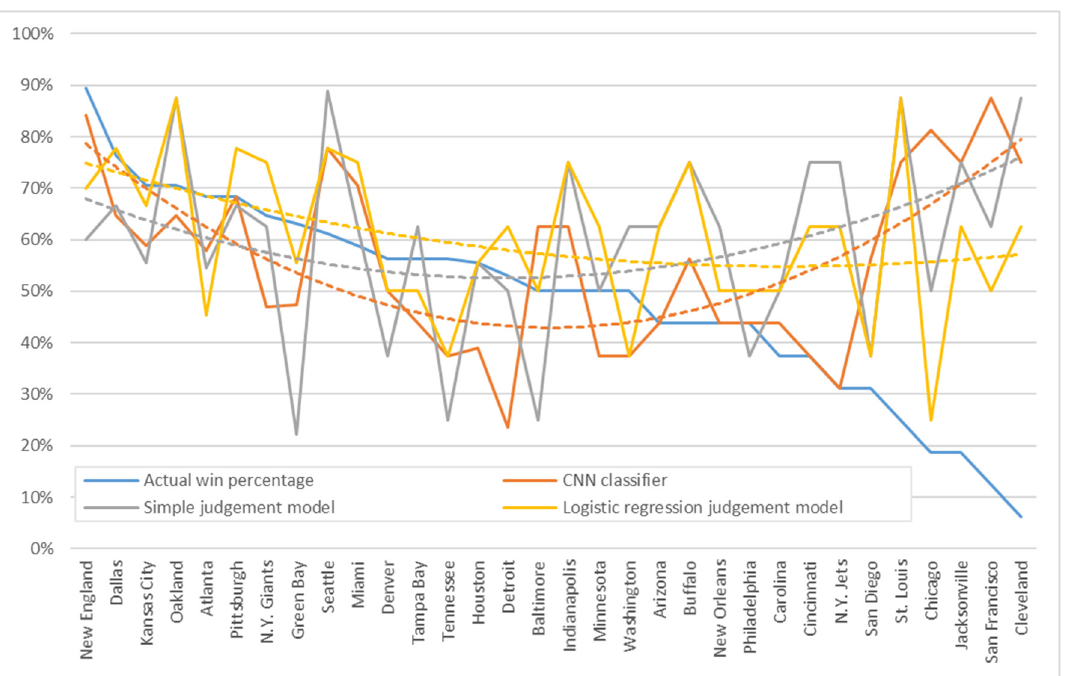
Figure 8. Accuracy comparison of the overall behavior (all teams).